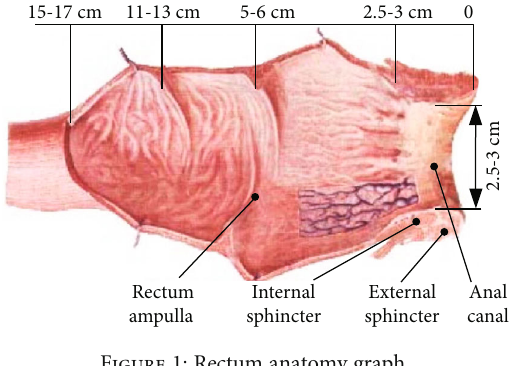
Figure 1: Rectum anatomy graph.